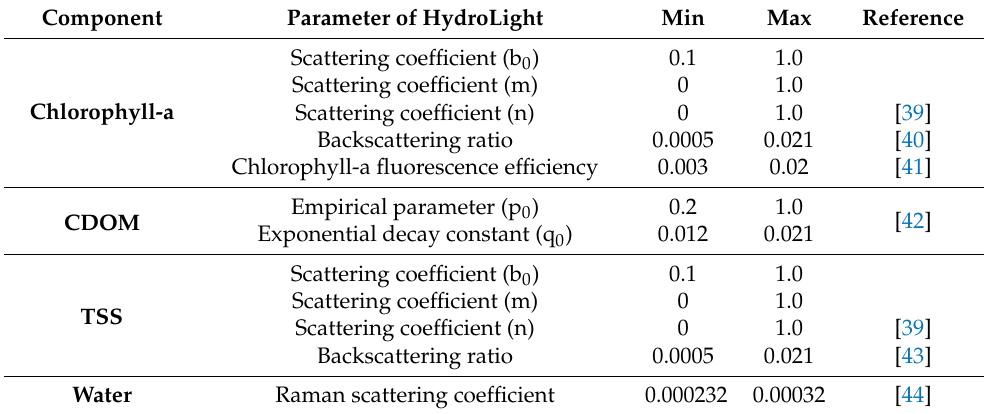
Table 1. Parameter information for sensitivity